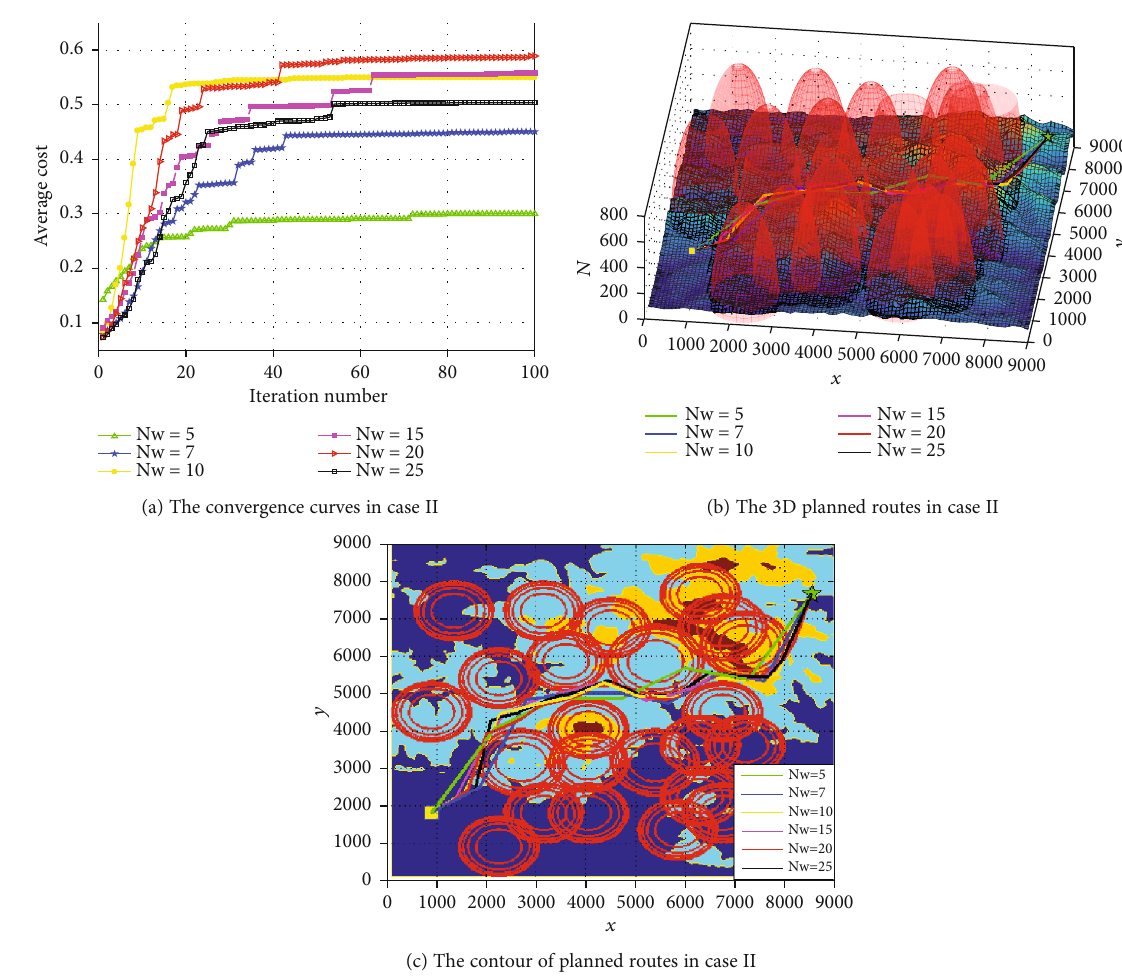
Figure 7: The comparison of results with di ff erent numbers in case